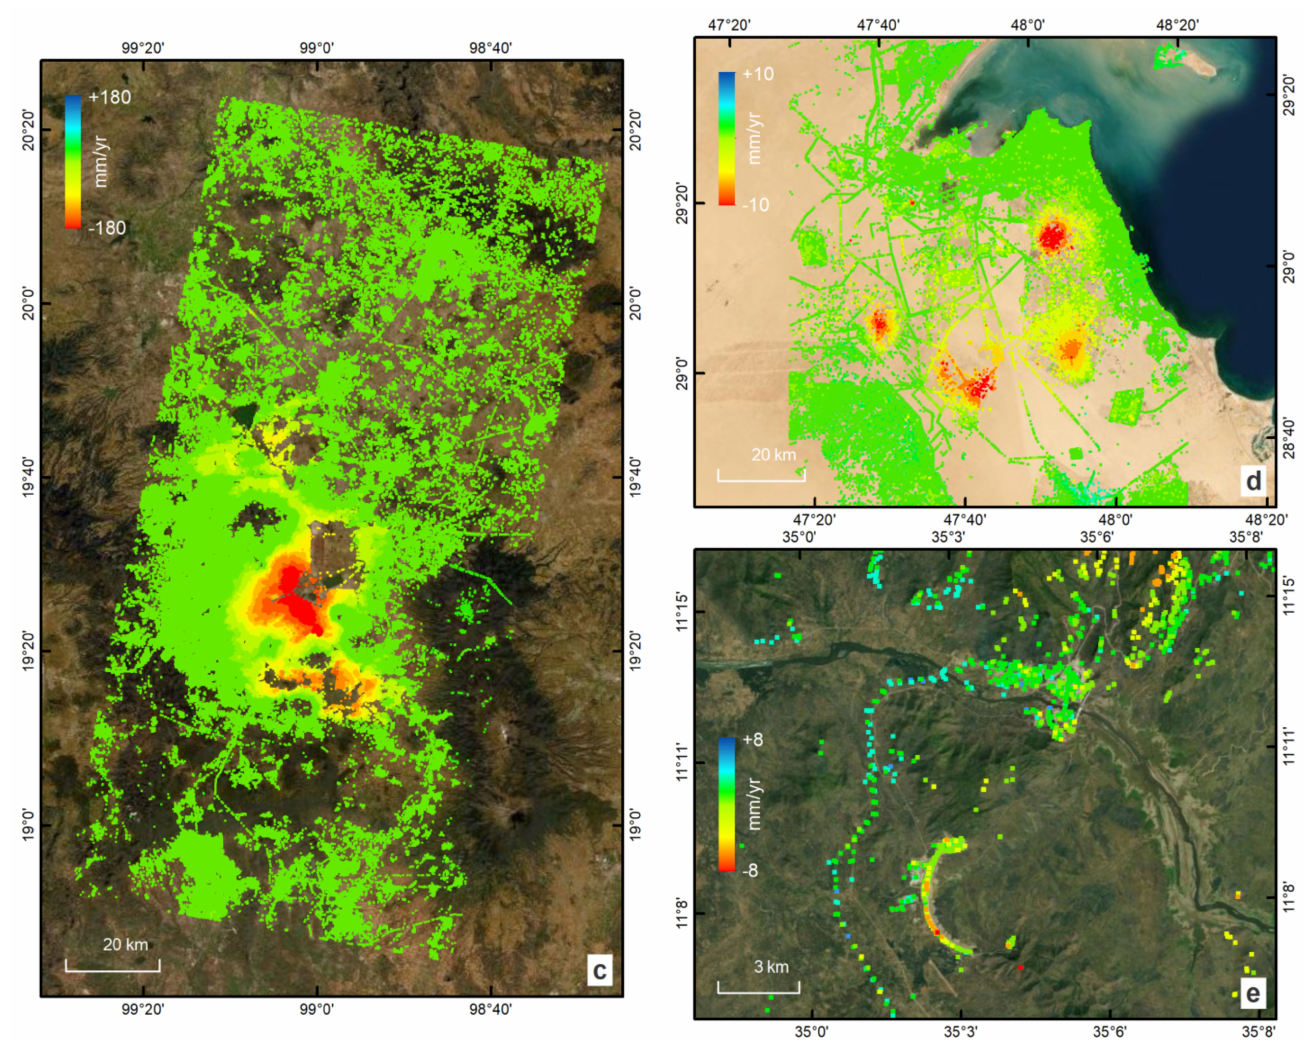
Figure 14. Sentinel-1 LoS motion rates using SNAPPING PSI Med service for various environ- ments ( a ) Santorini volcano, ( b ) San Francisco Bay area, ( c ) Mexico Valley, ( d ) Kuwait oil fields and ( e ) Grand Ethiopian Renaissance Dam. For details on each processing case please refer to the manuscript. Colour scale adjusted accordingly to optimize visualization. Contains modified Coperni- cus Sentinel-1 mission data (2015–2020), processed by AUTh on